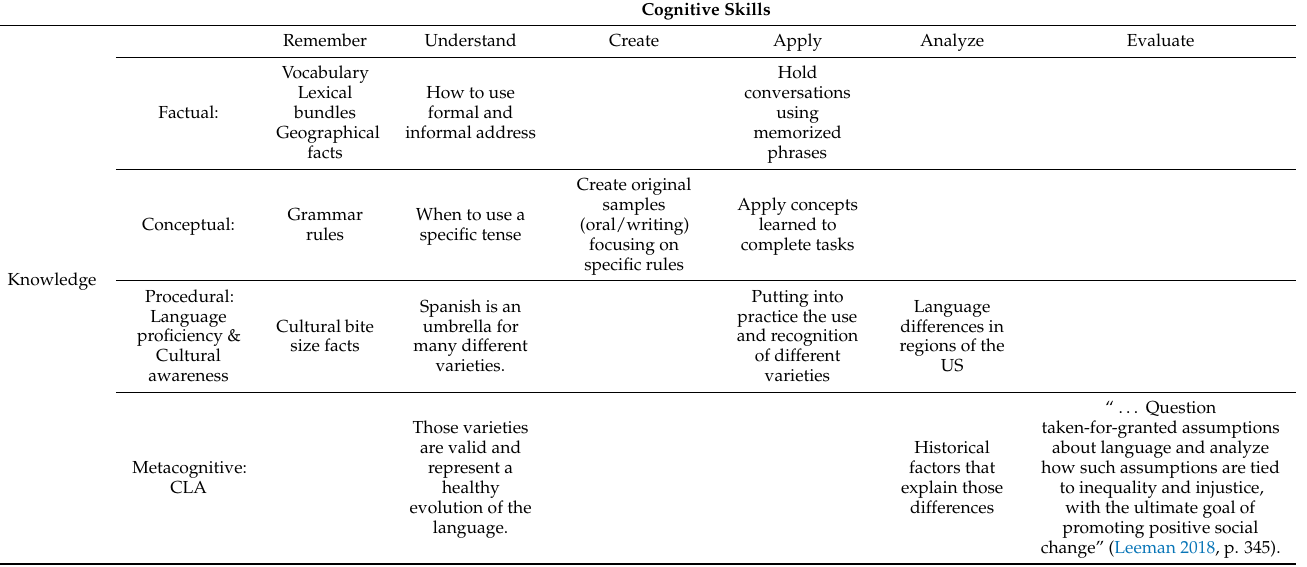
Table A1. Samples of World Language and CLA Objectives on the Revised Bloom Taxonomy